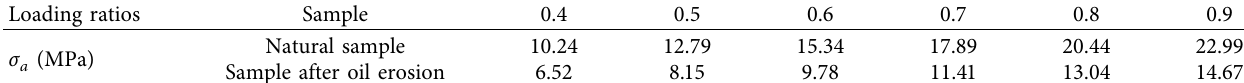
Table 1: Loading ratios ( k ) and the corresponding loading stresses.